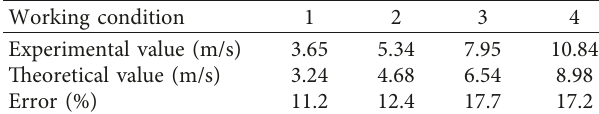
Table 2: Comparison and error of spectrum